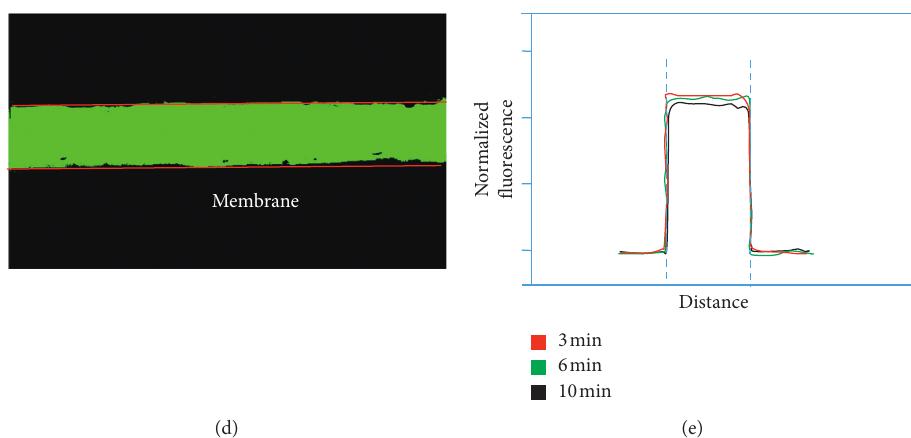
Figure 4: Transport of small molecule and macromolecule in the modified microfluidic network. (a) Schematic diagram of the modified microfluidic network shows that a membrane is constructed on the surface of channels. (b, d) Fluorescence distribution within the bulk matrix after injecting fluorescein and FITC-BSA solution into the channel for 10min, respectively. (c, e) Fluorescence intensity with respect to time after injecting fluorescein and FITC-BSA solution into the channel, respectively. The red full line indicates the modified channel within the bulk matrix (bar: 200 μ